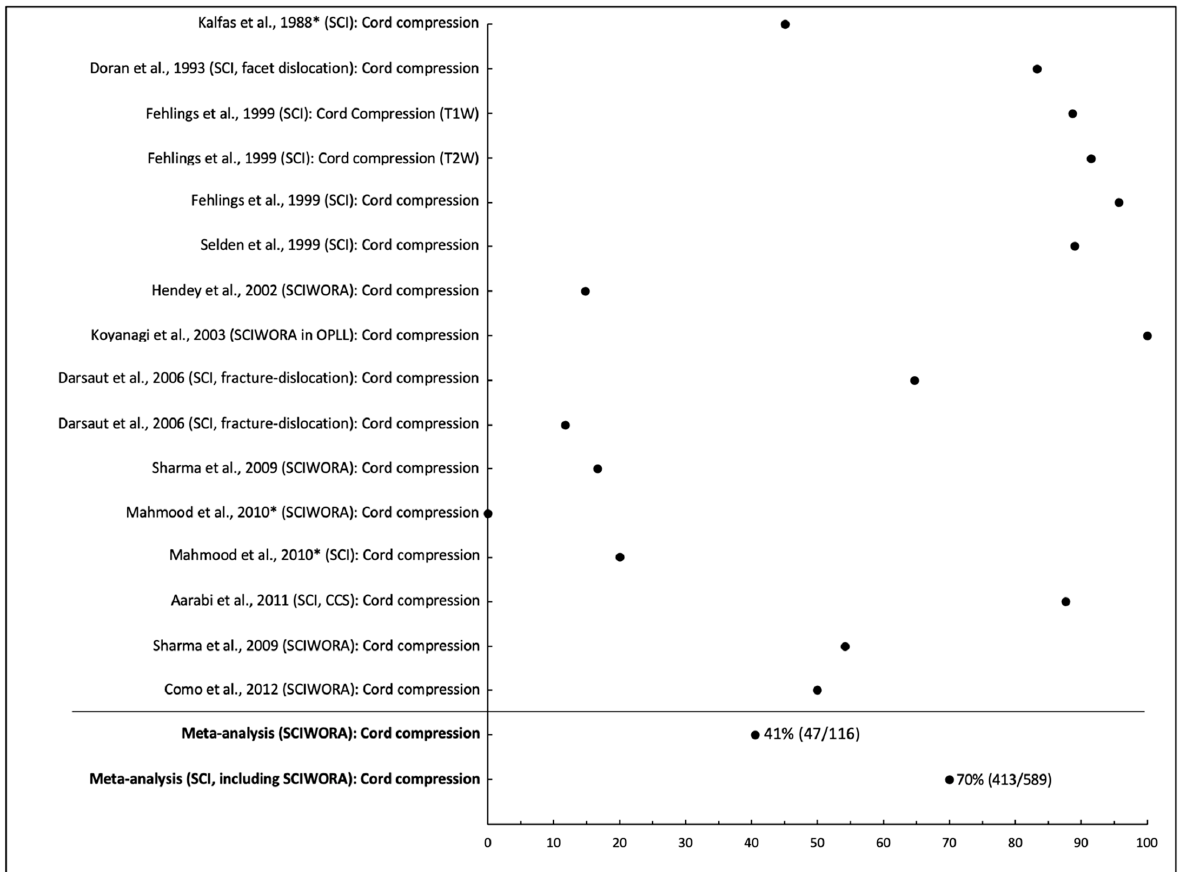
Figure 3. Frequency of cord compression on MRI in patients with acute spinal cord injury. * Studies that include pediatric patients (<16) or unspecified age range.